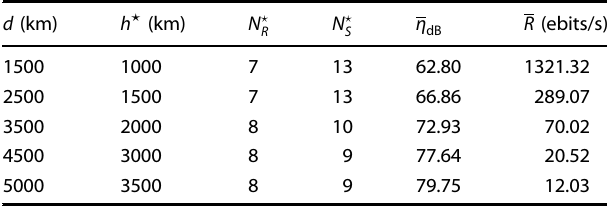
Table 1. Satellite con fi gurations ð N ? corresponding to the maxima of the curves for the fi gure of merit C ( h , d ) plotted in the central panel of Fig.